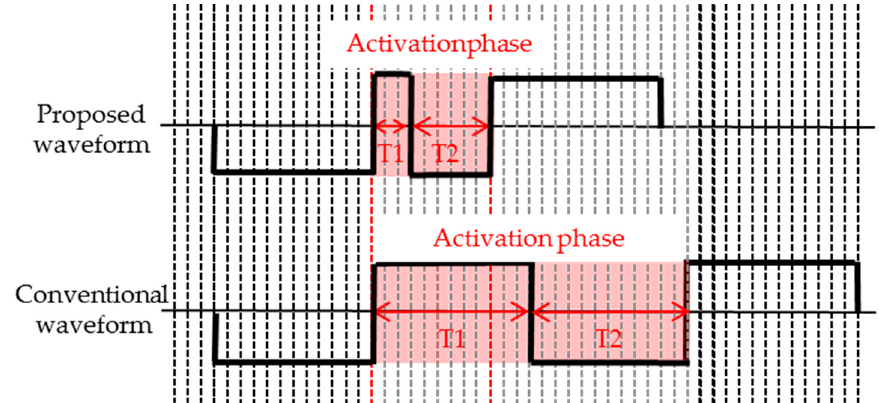
Figure 12. Driving timing comparison of activation phases in driving waveforms, and each vertical line represents 20 ms. In the proposed waveform, T1 is 60 ms and T2 is 120 ms. In the conventional waveform, T1 is 240 ms and T2 is 240 ms.